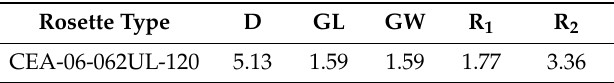
Table 1. Strain gauge rosette dimensions in mm; D: diameter gauge circle; GL: length gridlines; GW: width gridlines; R 1 : radius 1; R 2 : radius 2.